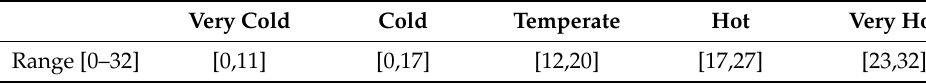
Table 1. Ambient temperature fuzzy sets ( ◦ C).